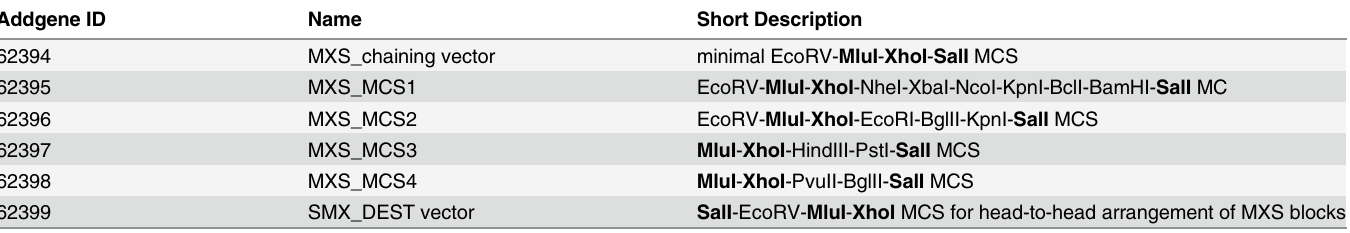
Table 2. Vectors compatible with the MXS-chaining strategy available from Addgene. Addgene